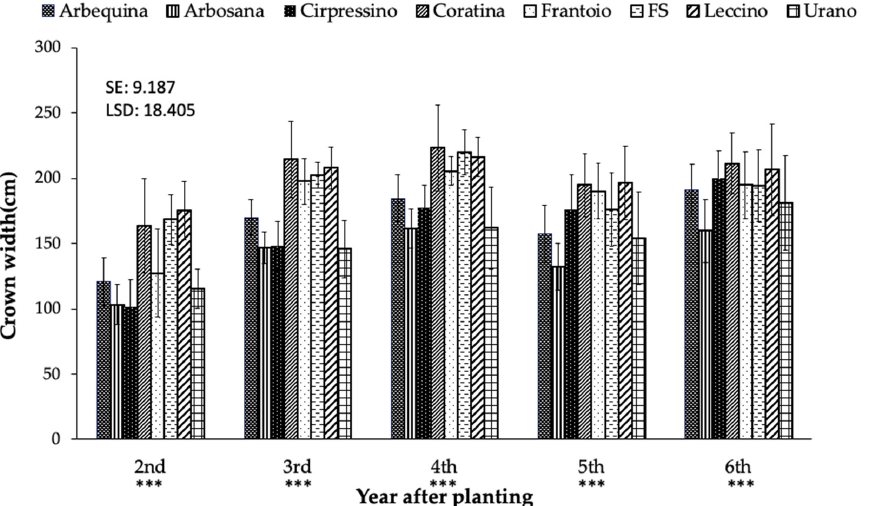
Figure 2. Effect of cultivar on tree transversal canopy width (W, cm) for each year. Standard error (SE) of the mean difference and least significant difference ( p < 0.001) are reported. Bars in each column indicate the standard deviation. *** means p < 0.001.